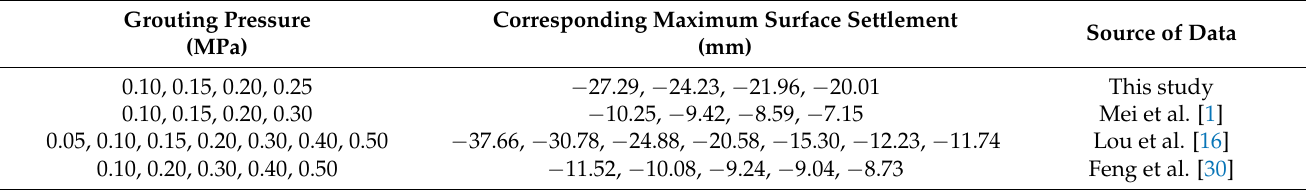
Table 4. Detailed data about maximum surface settlement under various grouting